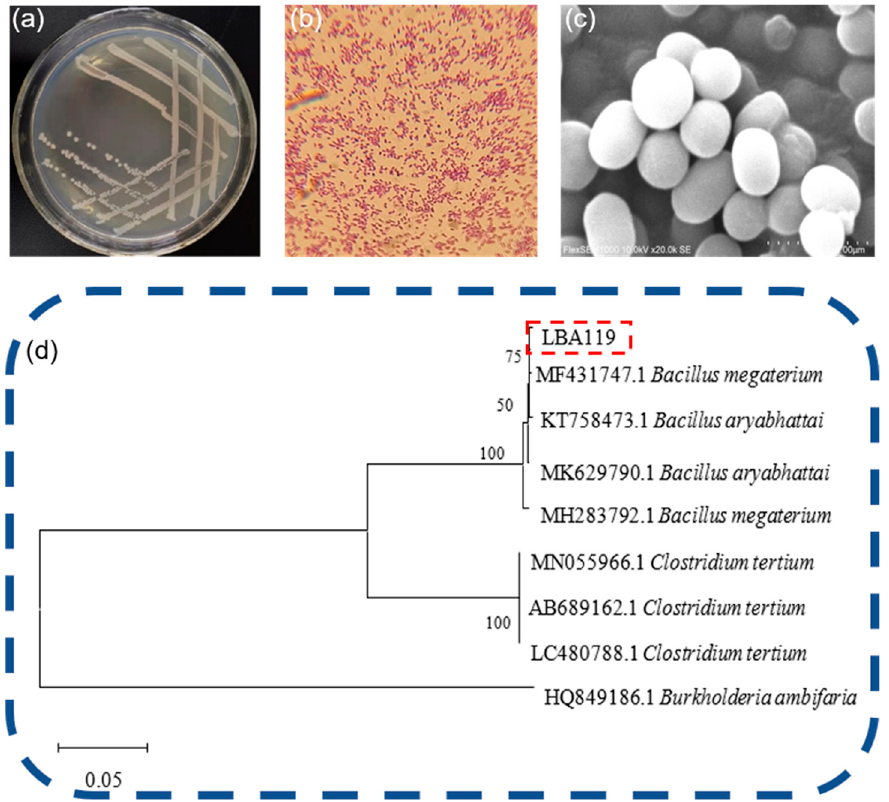
Figure 1. ( a ) LBA119 morphological growth diagram; ( b ) LBA119 Gram stain; ( c ) LBA119 electron microscope scan; ( d ) LBA119 phylogenetic tree.